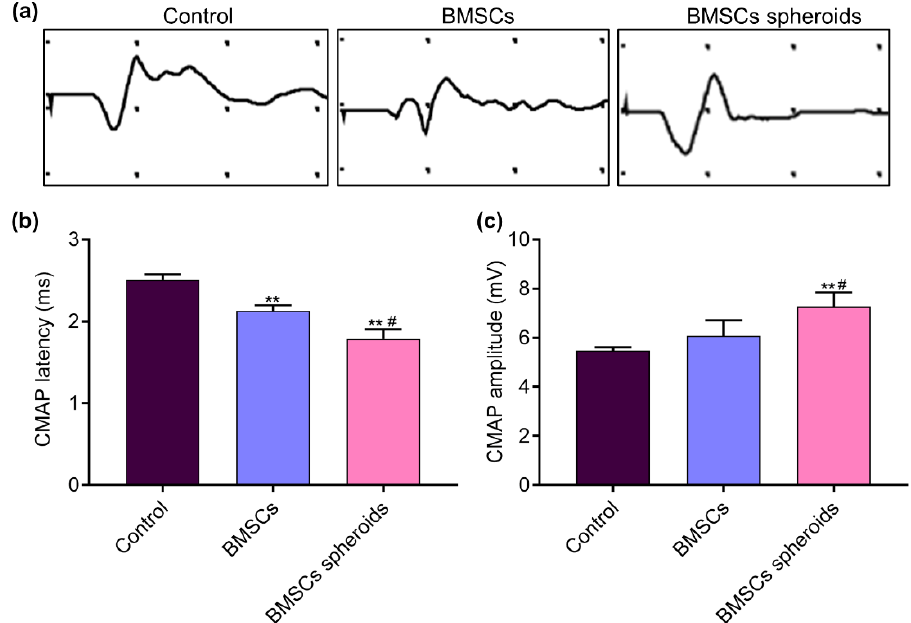
Figure 11. Electrophysiological examinations conducted 8 weeks after surgery. ( a ) Representative CMAP waveform at the operation side in each group. ( b ) Statistical analysis of CMAP latency. ( c ) Statistical analysis of CMAP amplitude. Data are expressed as mean ± SEM (n = 5 for each group). ** p < 0.01, vs. Control group; # p < 0.05, vs. BMSCs group (One-way analysis of variance followed by Kolmogorov–Smirnov and Shapiro–Wilk tests).